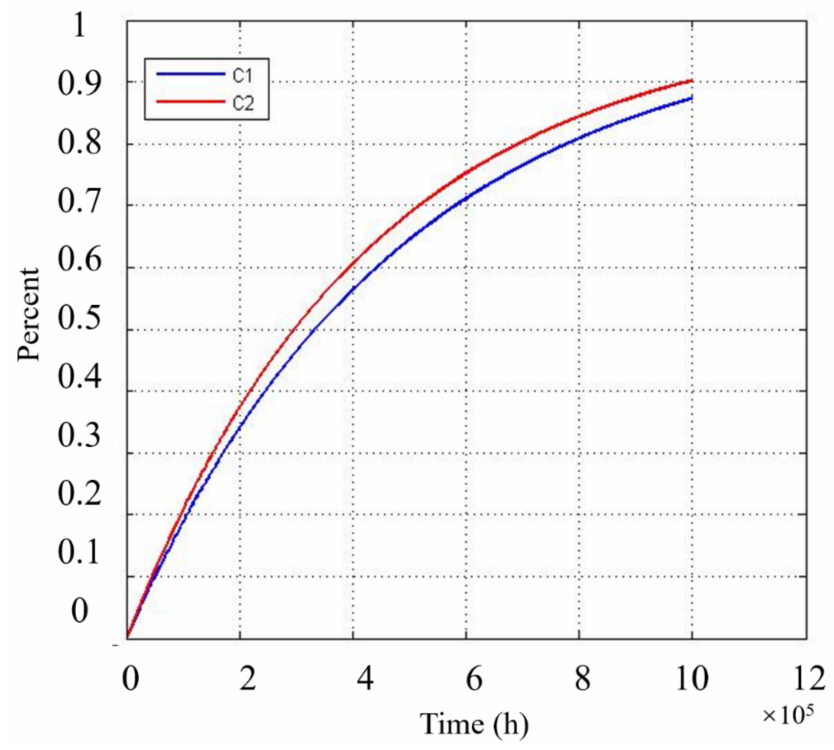
Figure 9. Failure probability distribution